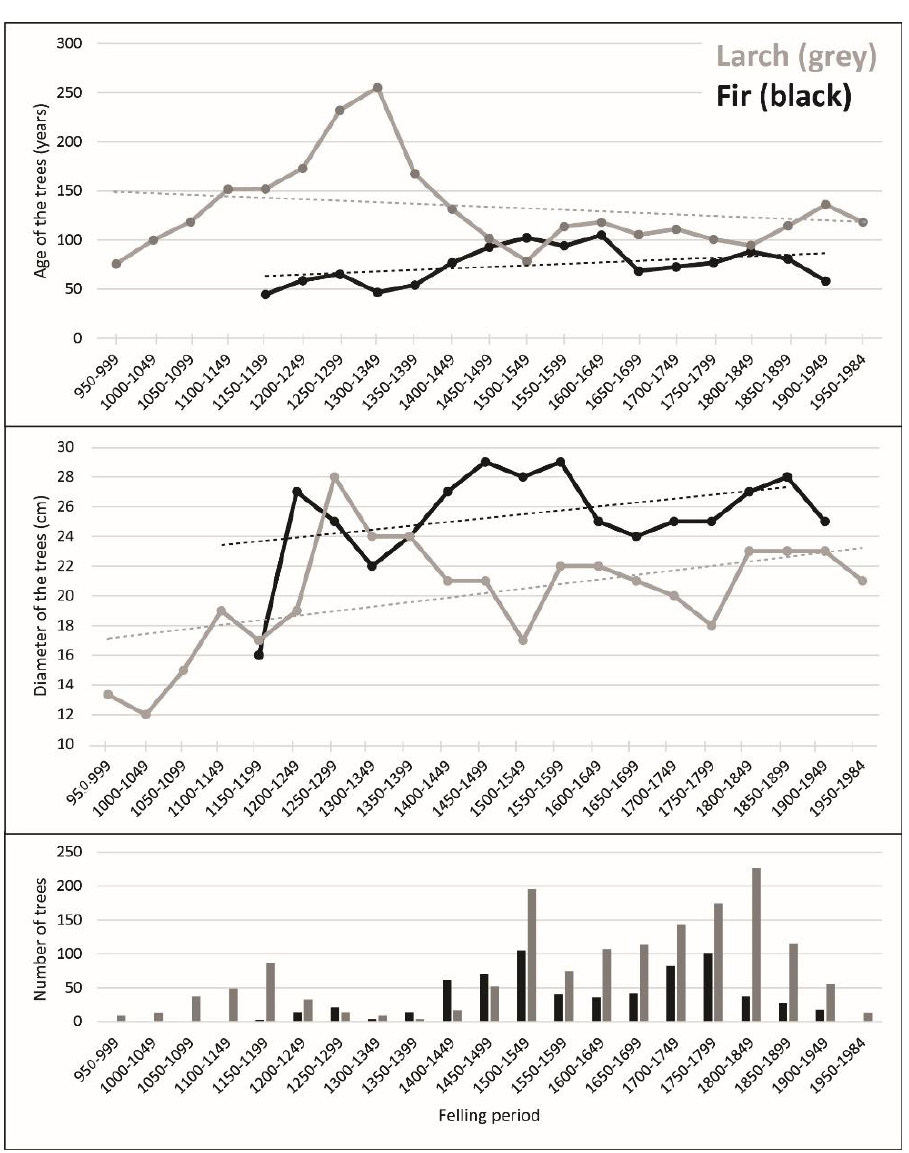
Figure 3. Comparison of the characteristics of archaeological larch (in black) and archaeological fir (in grey) over time. From top to bottom, tree age, tree diameter and number of trees, according to 50-year time windows based on the date of the last ring. In dotted lines, the associated trend curves.